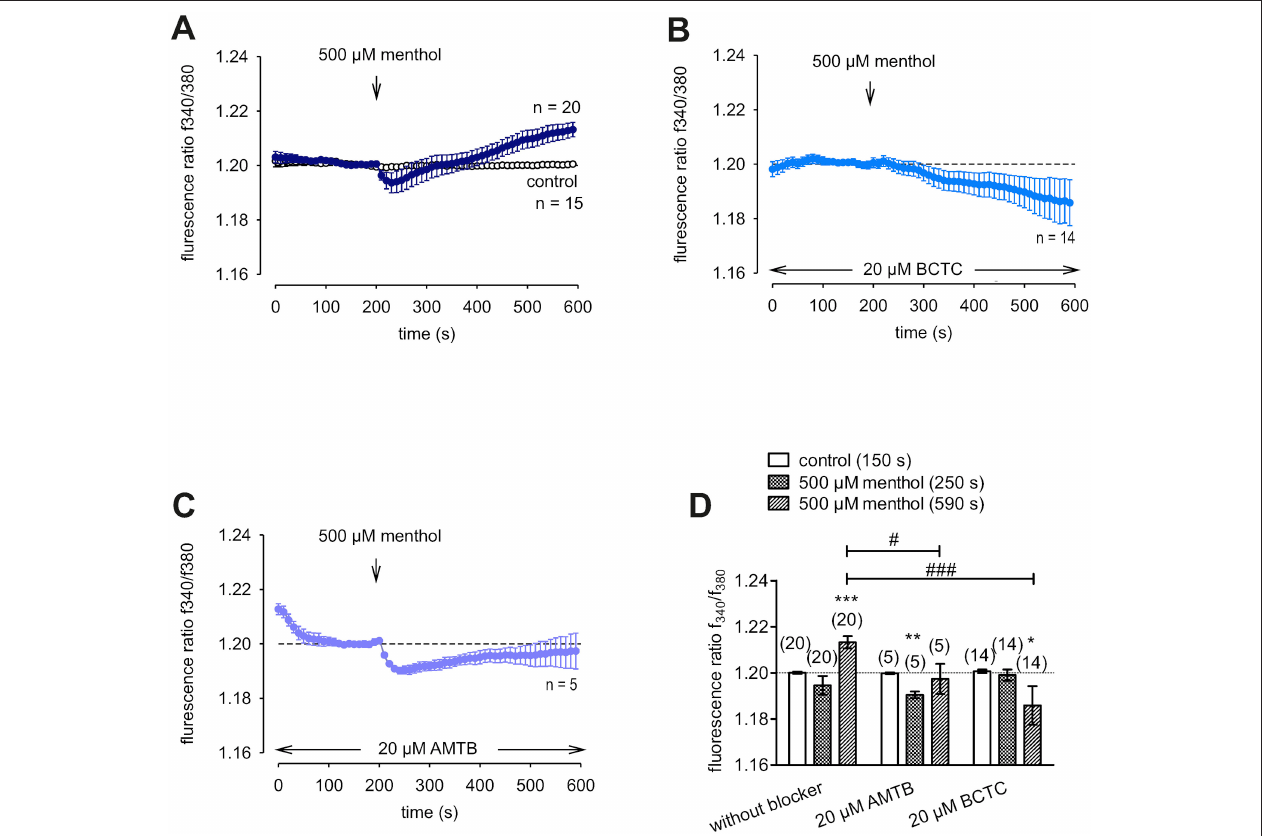
FIGURE 7 | Confirmation of functional TRPM8 expression in HCK. The pharmacological changes were carried out at the time points indicated by arrows. Data are mean ± SEM of 5-20 experiments. (A) Menthol (500 µ M) induced an irreversible increase in Ca 2 + influx ( n = 20) whereas non-treated control cells showed a constant Ca 2 + baseline ( n = 15). (B,C) Same experiments as shown in (A) , but in the presence of BCTC (B) , and AMTB (C) . Both AMTB and BCTC (both 20 µ M) clearly suppressed the menthol-induced Ca 2 + increase ( n = 5–14). (D) Summary of the experiments with menthol, AMTB, and BCTC. The asterisks (*) designate significance difference between with and without menthol, a TRPM8 agonist ( n = 5–20; p < 0.05 at the minimum; paired tested). The hashtags (#) indicate statistically significant differences of fluorescence ratios with and without BCTC or AMTB ( p < 0.05 at the minimum; unpaired